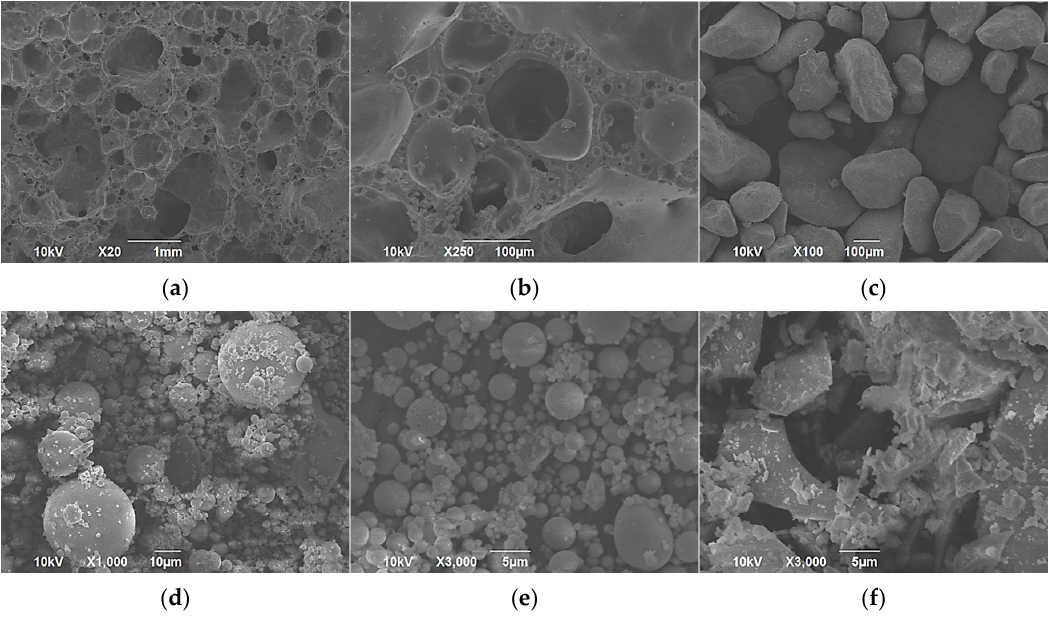
Figure 8. Microstructure of ( a ) LECA Mag. 20, ( b ) LECA Mag. 250, ( c ) DS Mag. 100, ( d ) FA Mag. 1000, ( e ) FA Mag. 3000, and ( f ) GGBS Mag. 3000. ( e ) FA Mag. 3000, and ( f ) GGBS Mag.